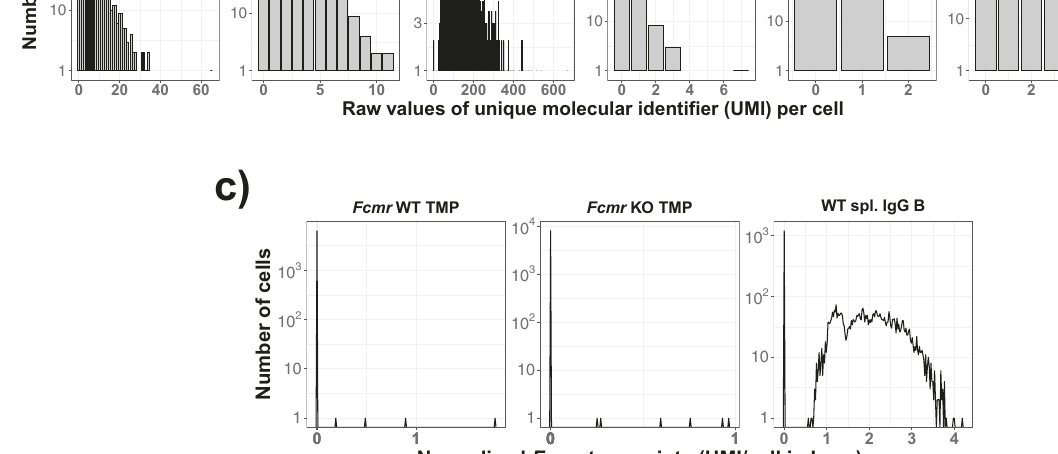
NATURE COMMUNICATIONS| (2022) 13:3951